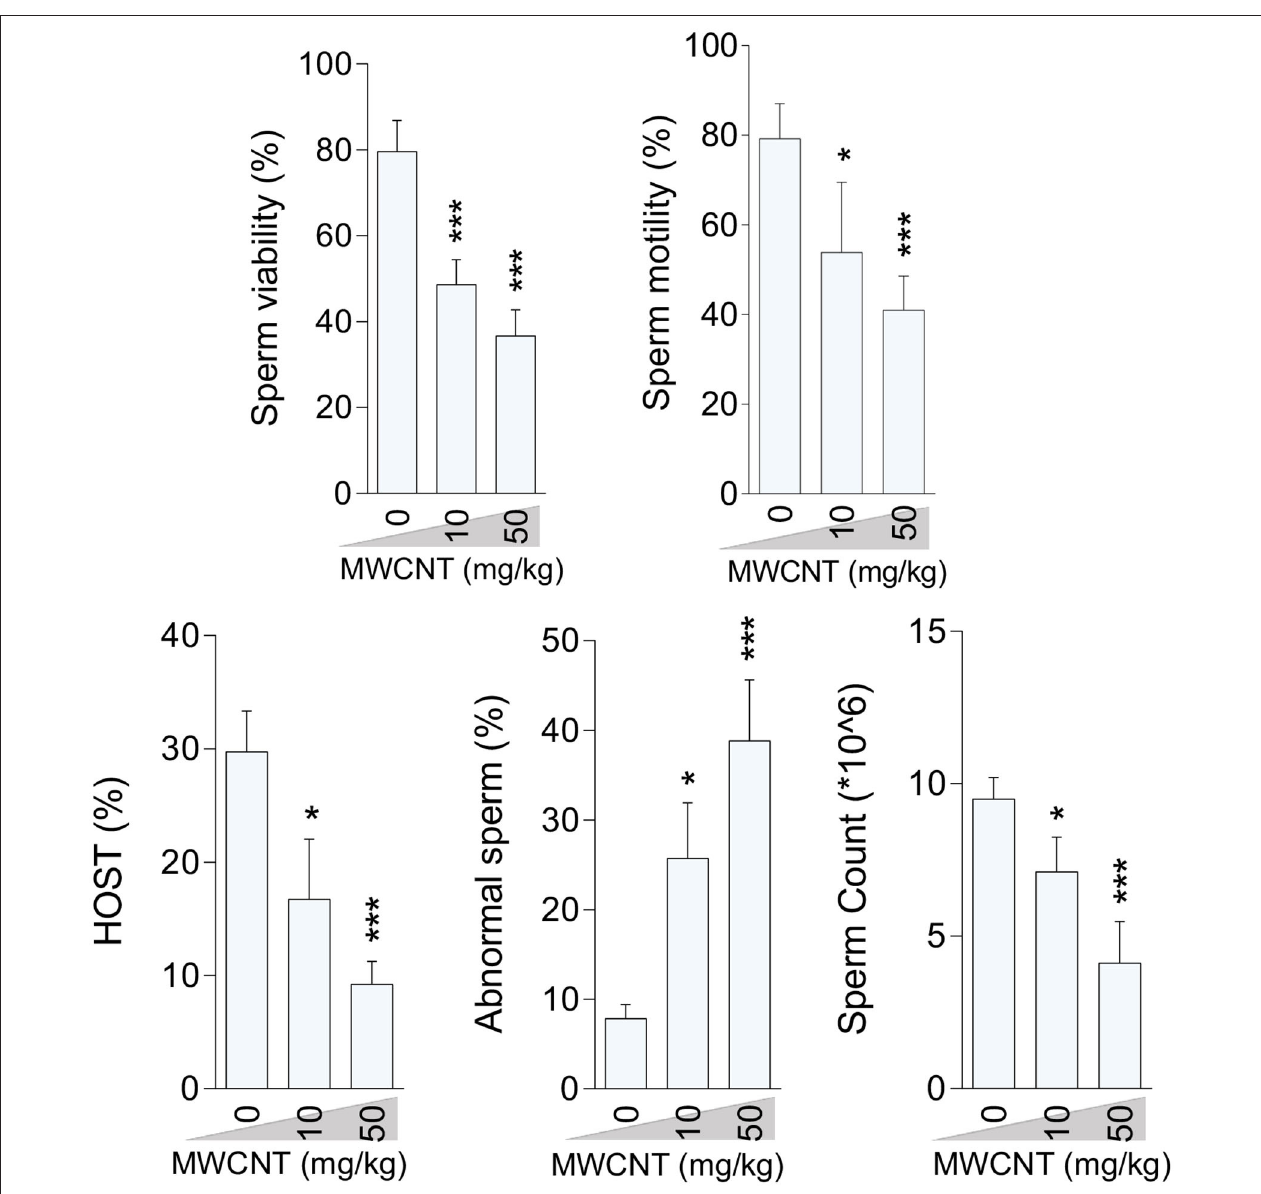
FIGURE 4 | Effect of multi-walled carbon nanotubes (MWCNT) on epididymal sperm parameters in mice (mean ± SEM, n = 6). Asterisks indicate significantly different from the control (0 ppm) group (* P < 0.05, *** P < 0.001).